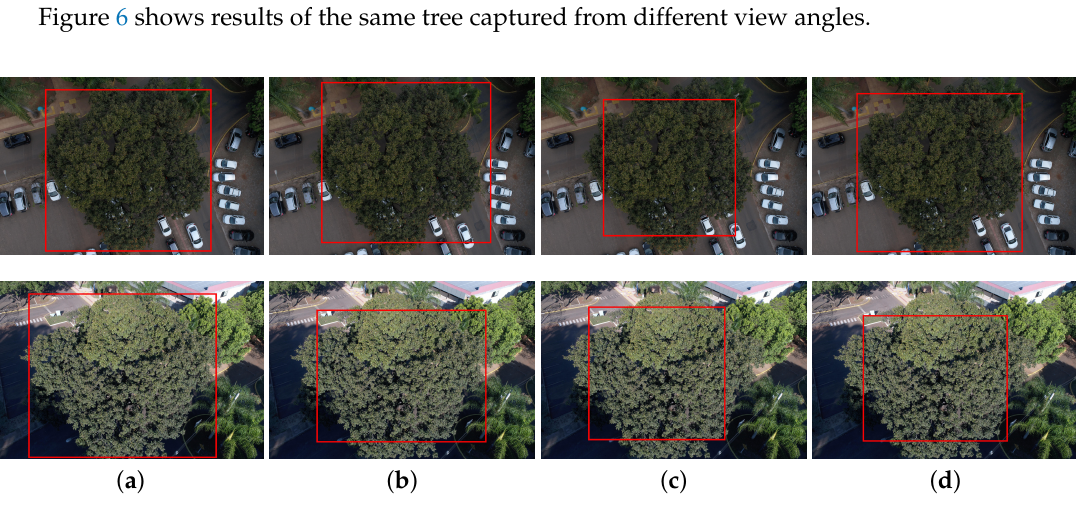
Figure 6. Examples of detection results in images with different capture angles (0 ◦ and 30 ◦ ): ( a ) ground truth; ( b ) Faster-RCNN; ( c ) YOLOv3; and ( d )